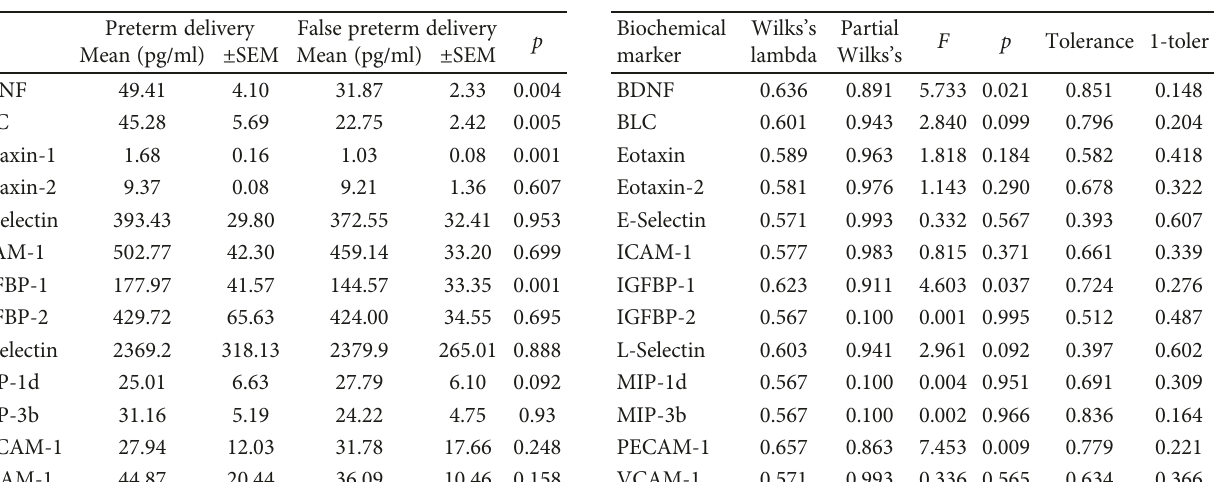
Table 2: Comparison of concentration levels of the analyzed markers between preterm delivery and false preterm delivery groups.